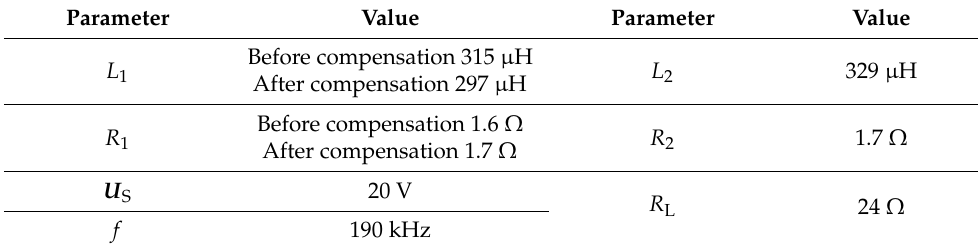
Table 1. Parameters of DD couplers.